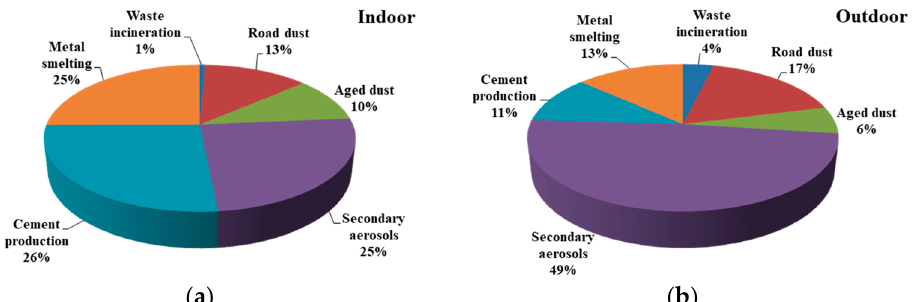
Figure 6. Factor profile of PMF results.